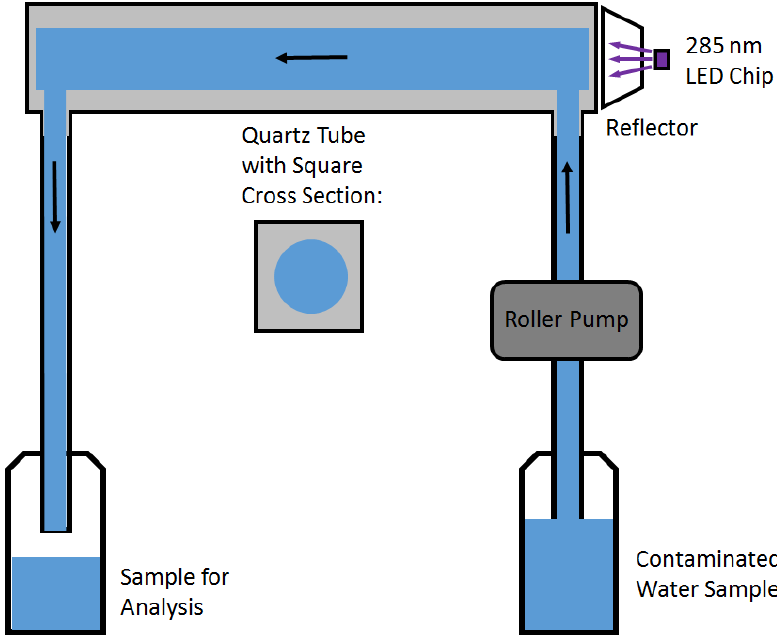
Figure 1. Schematic setup of the disinfection system.